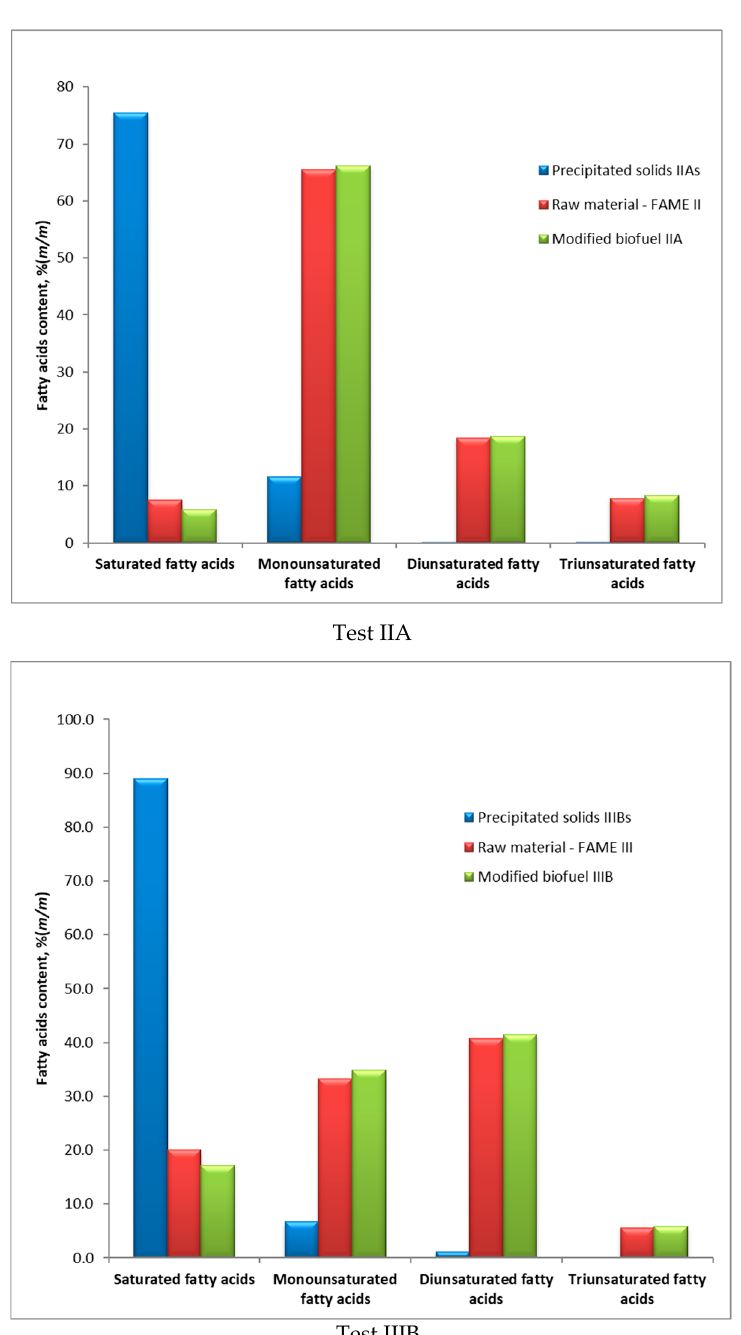
Figure 5. The impact of dewaxing on a change of fatty acids content versus the degree of their unsaturation in raw materials and products obtained in tests IIA and IIIB.